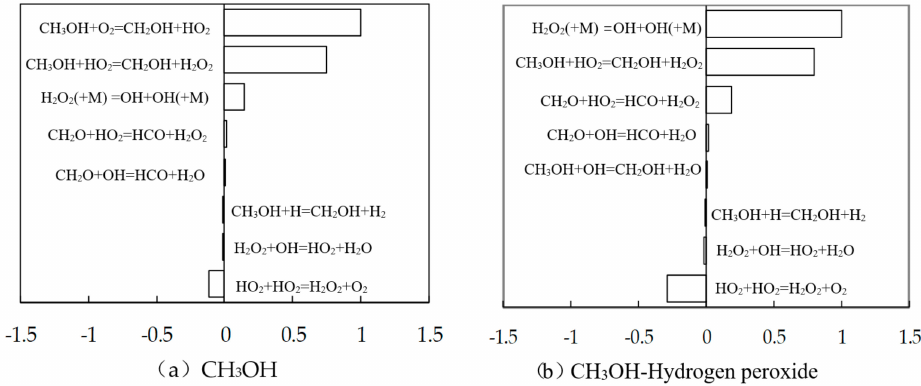
Figure 7. Combustion analysis sensitivity of methanol and methanol–hydrogen peroxide hybrid fuel.